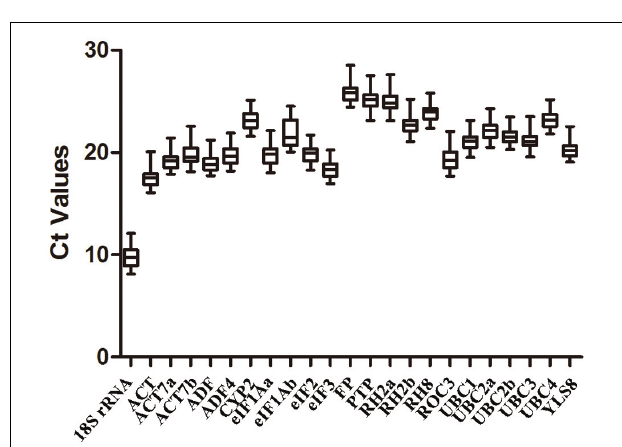
FIGURE 2 | Average cycle threshold (Ct) values for the 23 candidate reference genes upon duration of latex flow.